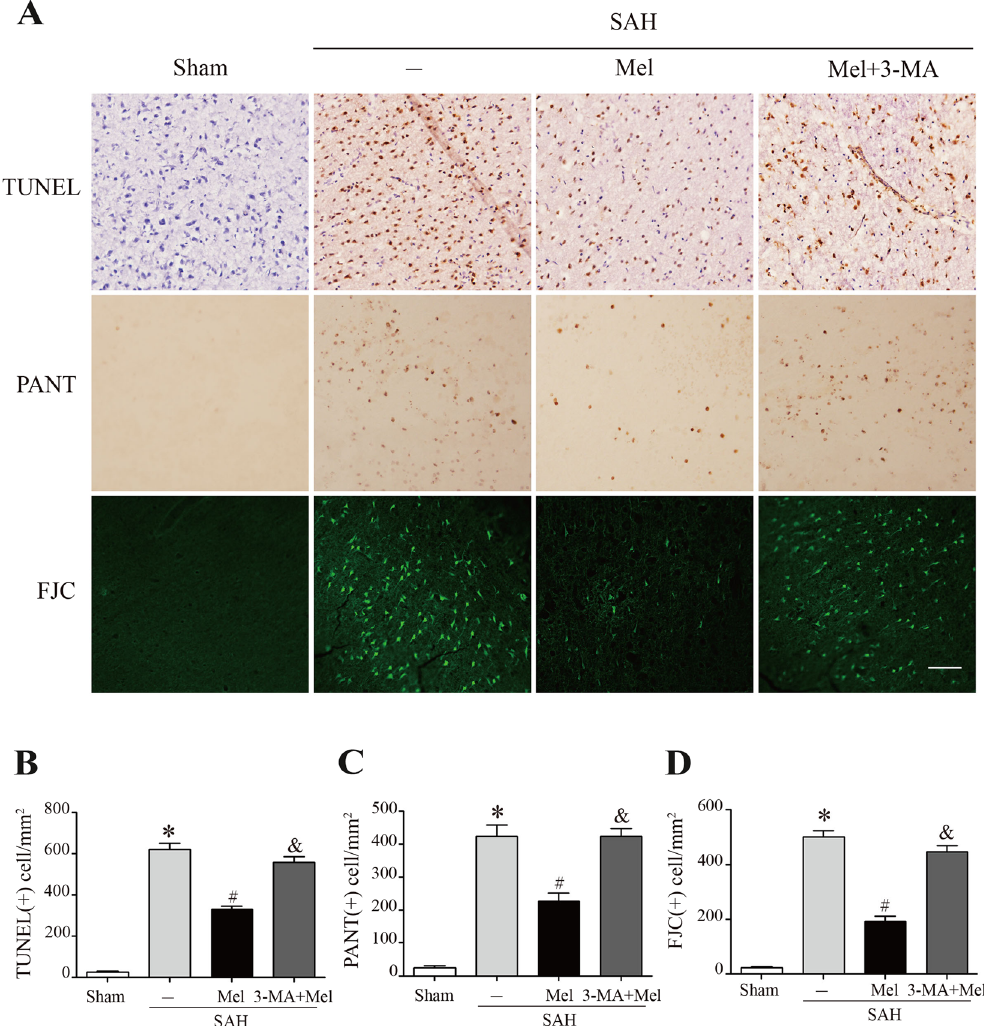
Figure 6. Effect of melatonin treatment on neuronal cell death. ( A ) Representative micrographs showing TUNEL, PANT and Fluoro-Jade C staining in the ipsilateral basal cortex at 24 h after SAH. Scale bar = 50 μ m. ( B – D ) The quantification of TUNEL-positive cells, PANT-positive cells, and Fluoro-Jade C-positive cells. * P < 0.05 versus sham group, # P < 0.05 versus SAH + vehicle group, and & P < 0.05 versus SAH + Mel